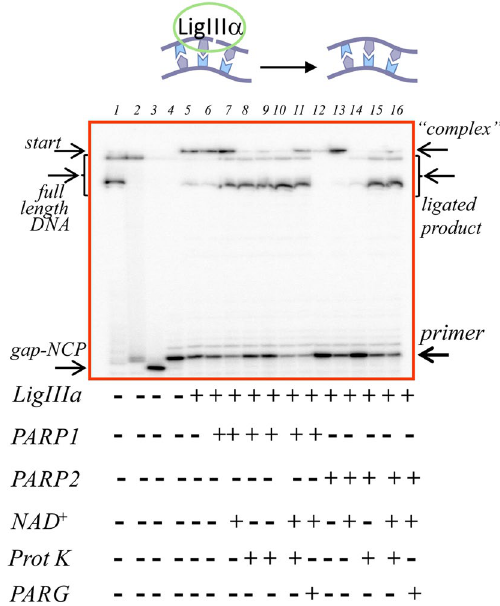
Figure 5. The LigIIIα activity on nicked substrate out-NCP. Product separation after the sealing of 5 ′ [ 32 P] labelled nicked out-NCP by LigIIIα with PARP1 or PARP2 and PARylation in the presence of XRCC1. Lane 1: native out-NCP; lane 2: out-NCP incubated with UDG; lane 3: out-NCP incubated with UDG and APE1; lane 4: out-NCP incubated with UDG, APE1, Polβ and dTTP, resulting in nicked out-NCP; lanes 5–16: nick sealing in the presence of LigIIIα (lanes 5, 8) and PARP1 (lanes 6, 9) or PARP2 (lanes 12, 14) without or with NAD + (lanes 7, 10, 11 and 13, 15, 16, respectively). Lanes 8–10 and 14–15 correspond to lanes 5–7 and 12–13 with an additional treatment (with proteinase K), respectively. Lanes 11 and 16 correspond to lanes 7 and 13